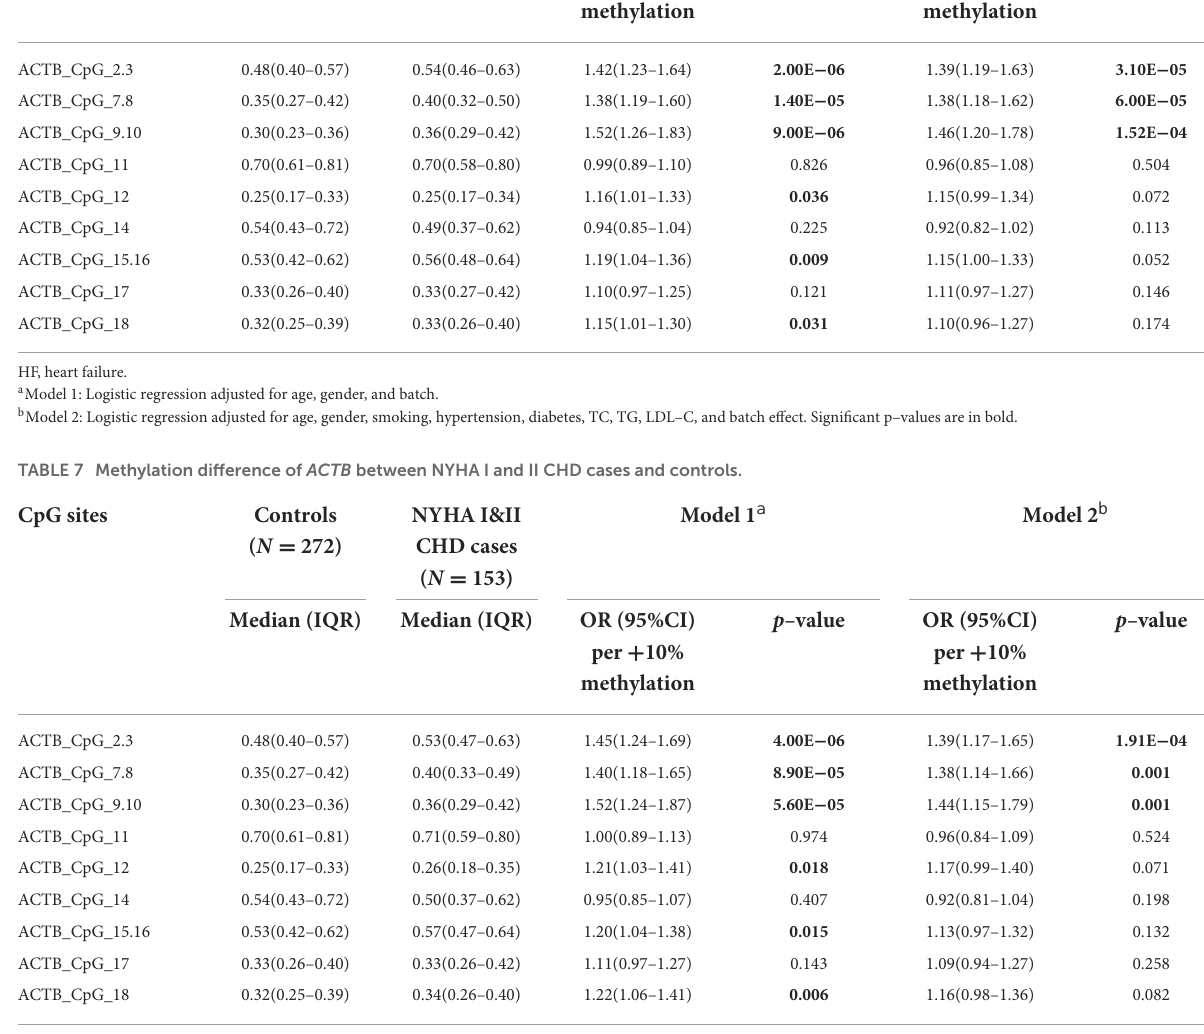
Figure 2, Supplementary Table 14]. When all measurable ACTB CpG sites were considered, the methylation level of ACTB showed a moderate discriminatory power (AUC = 0.75, 0.74, 0.74, and 0.76, respectively, logistic regression model b; Supplementary Table 14). Thus, compared to the six CpG sites (ACTB_CpG_2.3, ACTB_CpG_7.8, and ACTB_CpG_9.10), the discriminatory power could hardly be improved when all CpG sites in the ACTB amplicon were included in the models (Supplementary Table